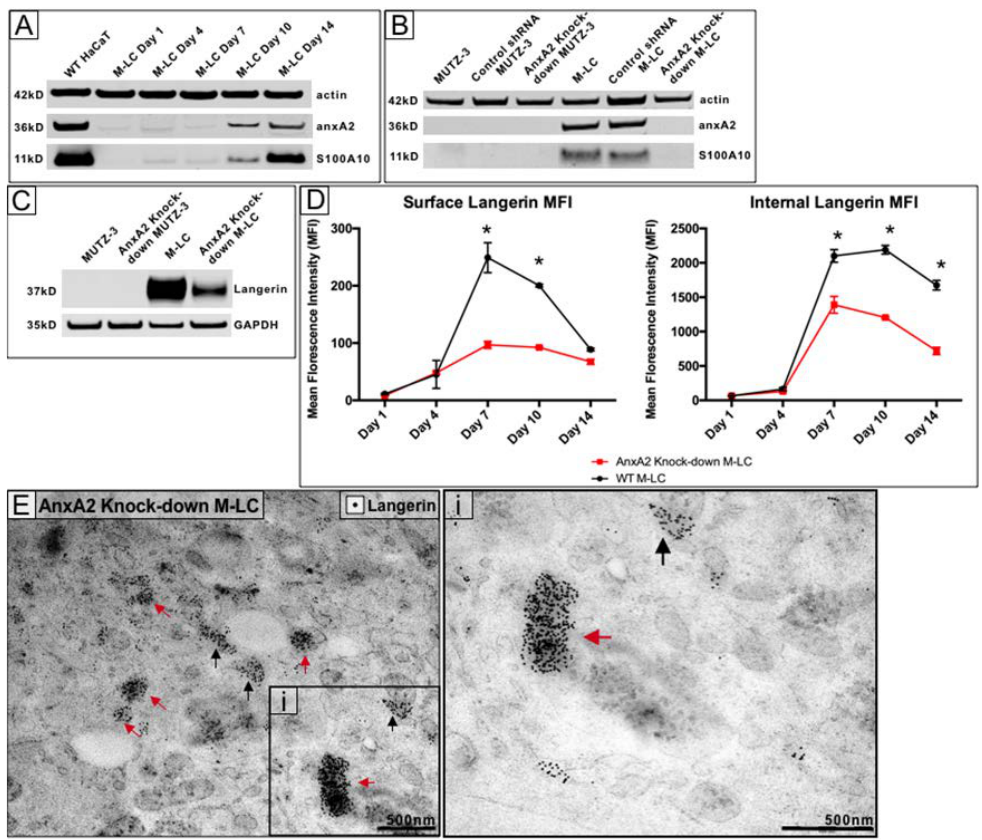
Figure 3. A2t knockdown in M-LC causes a decrease in langerin expression and aberrant cytoplasmic localization. ( A ) M-LC were collected throughout the 14-day differentiation for analysis of A2t expression via Western blot. The human keratinocyte cell line HaCaT were used as a positive control; ( B ) Western blot of MUTZ-3 and fully differentiated, day-14 M-LC show successful A2t knockdown in M-LC; ( C ) At day 14 of differentiation, langerin expression is decreased with A2t knockdown as compared with the WT M-LC; ( D ) Surface and internal langerin expression was assessed via flow cytometry in both wild type and A2t knockdown MUTZ-3 throughout differentiation. Data represents three biological replicates ( n = 9) (* p < 0.05, paired Student’s t -test); ( E ) Black arrows indicate langerin labeling specific to BG and red arrows show abnormal, non-BG associated langerin clusters.